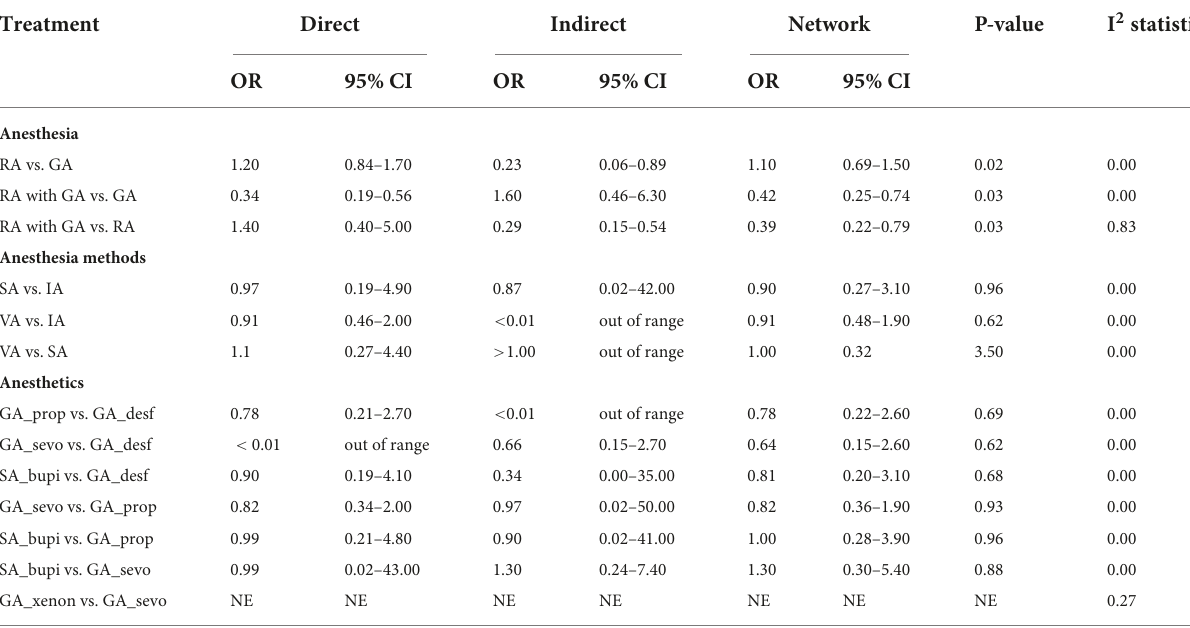
TABLE 4 Results of consistency and